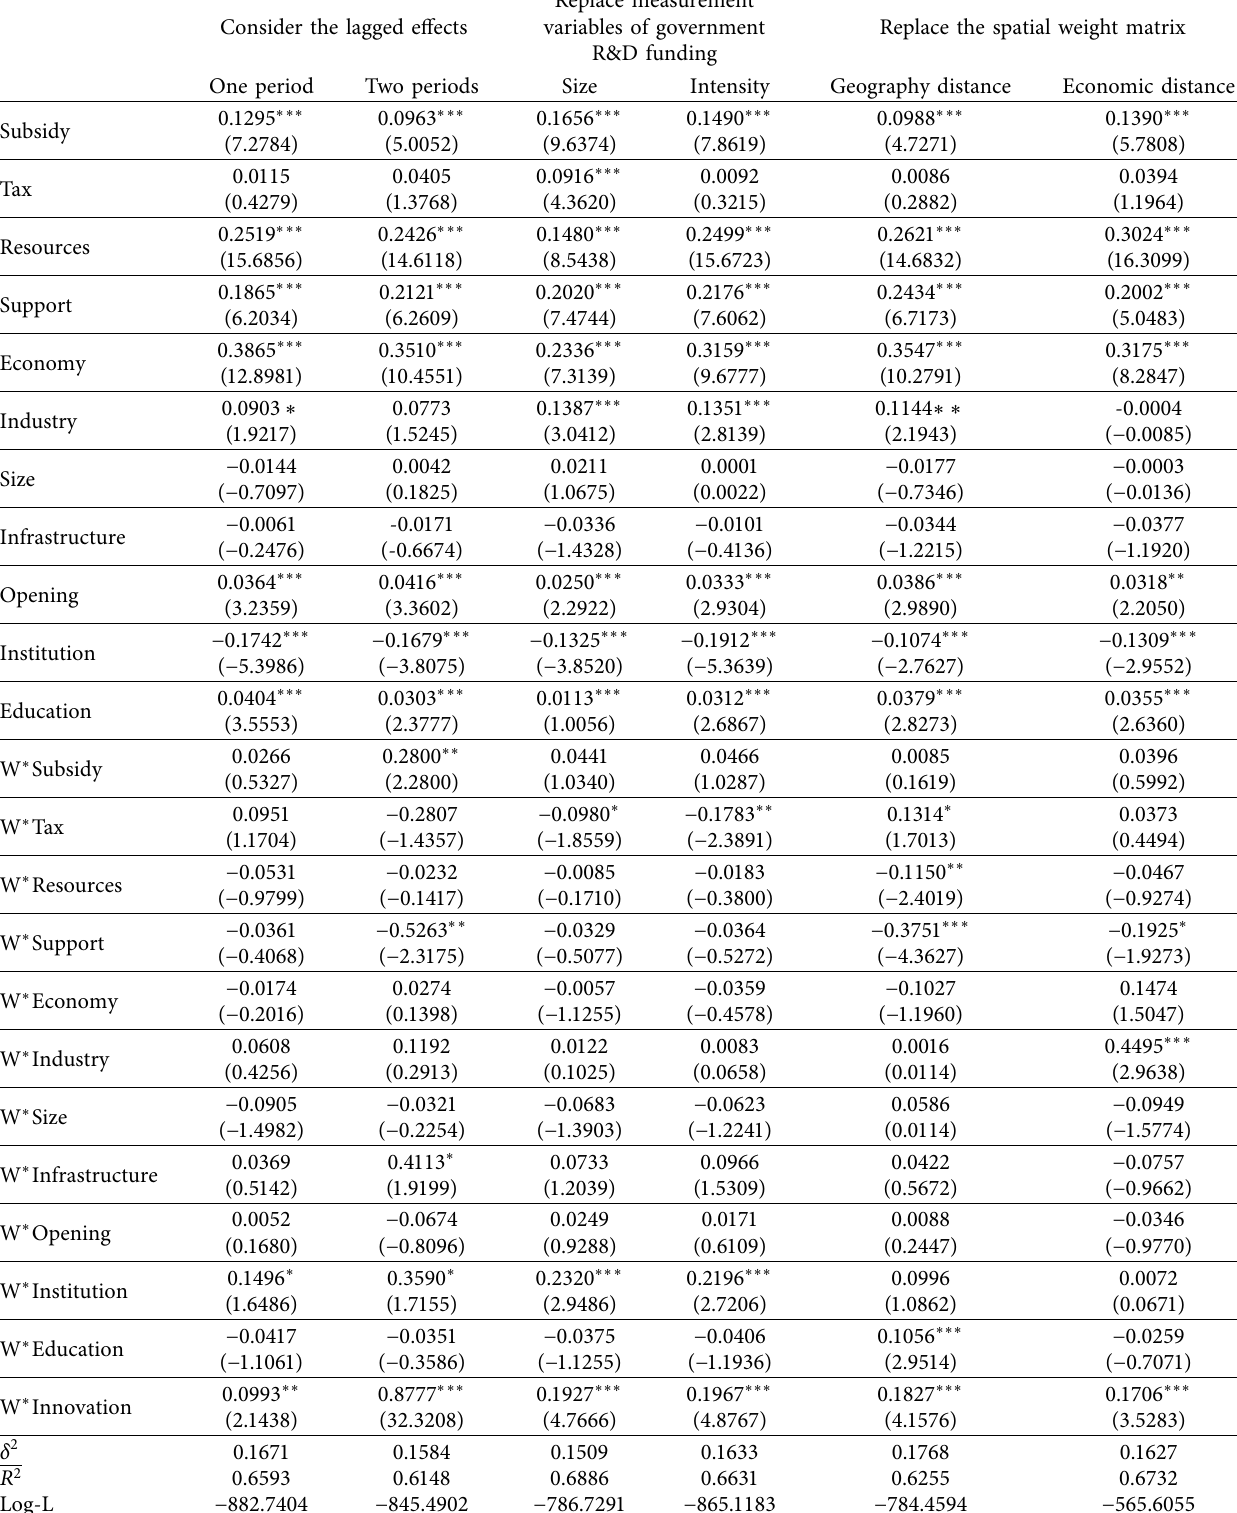
Table 6: Results of the robustness